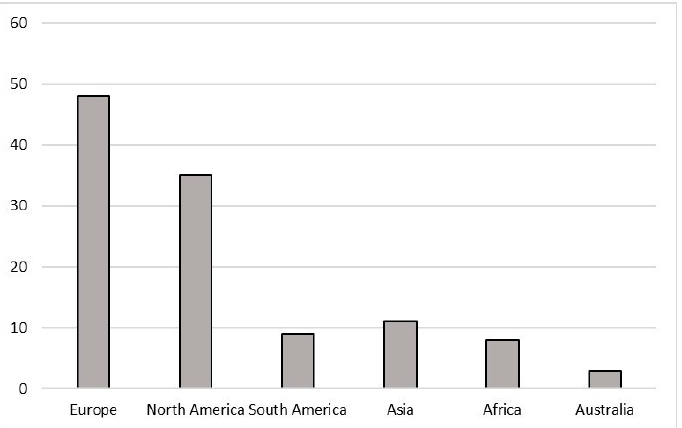
Figure 1. Number of studies, conducted on Apis mellifera , and divided by continent, that met the criteria for inclusion in this